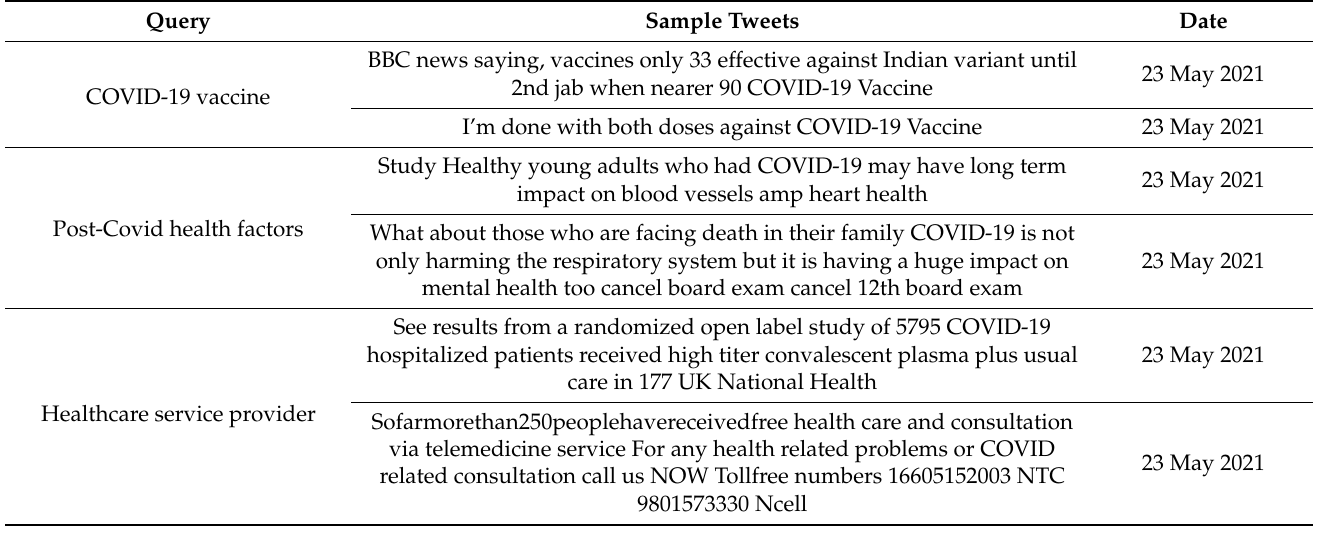
Table 2. Collected tweets sample.